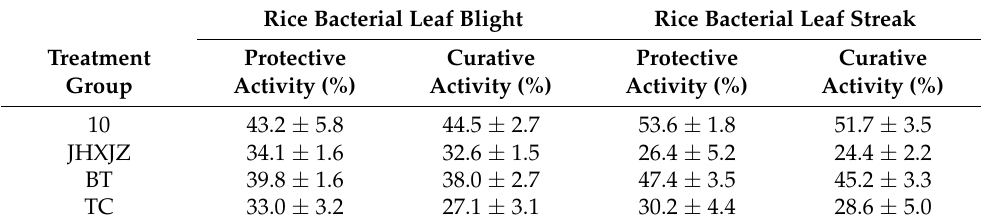
Table 5. Protective and curative activities of compound 10 against two rice bacterial diseases at 200 mg/L.